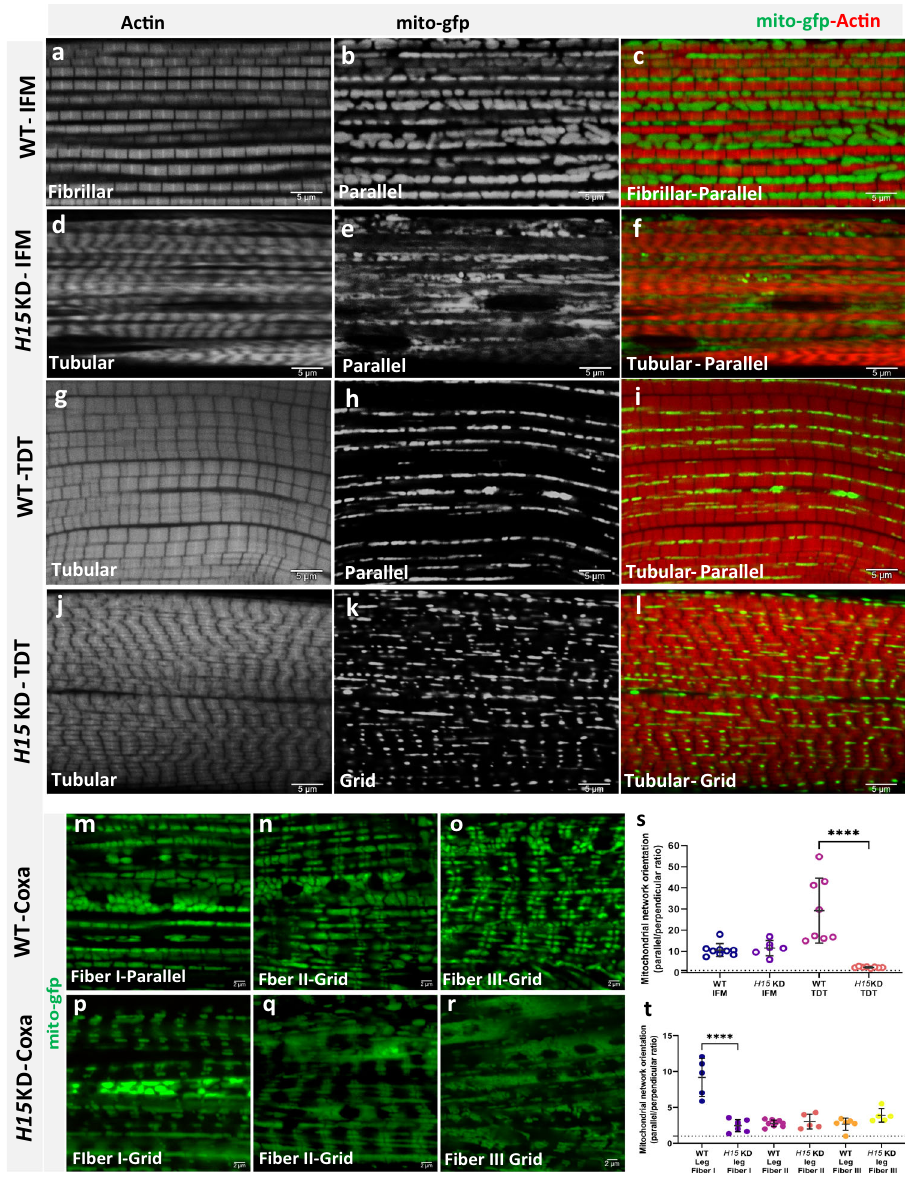
Fig. 4 | H15 independently regulates the conversion ofmuscle contractile type and mitochondrial network con fi guration in Drosophila muscles. a , b , c Fibrillar fl ightmuscles(IFMs)stainedforF-actin(phTRITC)andmitochondria (mito-GFP) showing parallel aligned mitochondria between myo fi brils. d H15 KD shows fi brillar muscles switched to tubular muscle type. e , f H15 KD muscles show parallel mitochondria along muscle fi bers. g , h , i Tubular jump muscles show parallelmitochondria(thinandelongated). j H15 KDinjumpmusclesshowstubular fi bers (phTRITC). k , l Upon H15 KD, tubular jump muscles show a change in mito- chondrialnetworkstomoregrid-like(ScaleBars:5 μ mforall). m Wildtypecoxaleg muscle Fiber I showing parallel mitochondrial networks. n Wildtype leg muscle Fiber II and o Fiber III showing grid-like mitochondrial networks. p H15 KD leg muscleFiberIshowingconversiontoagrid-likemitochondrialnetwork. q , r H15 KD